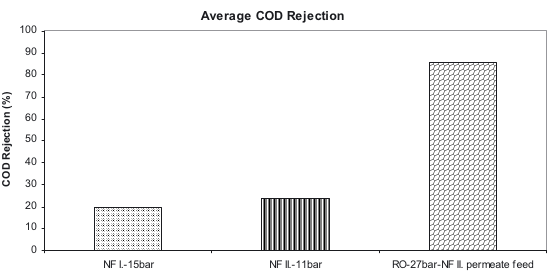
Figure 8. Average COD rejection of the applied membrans in case of dumpsite leachate (wastewater of low COD).